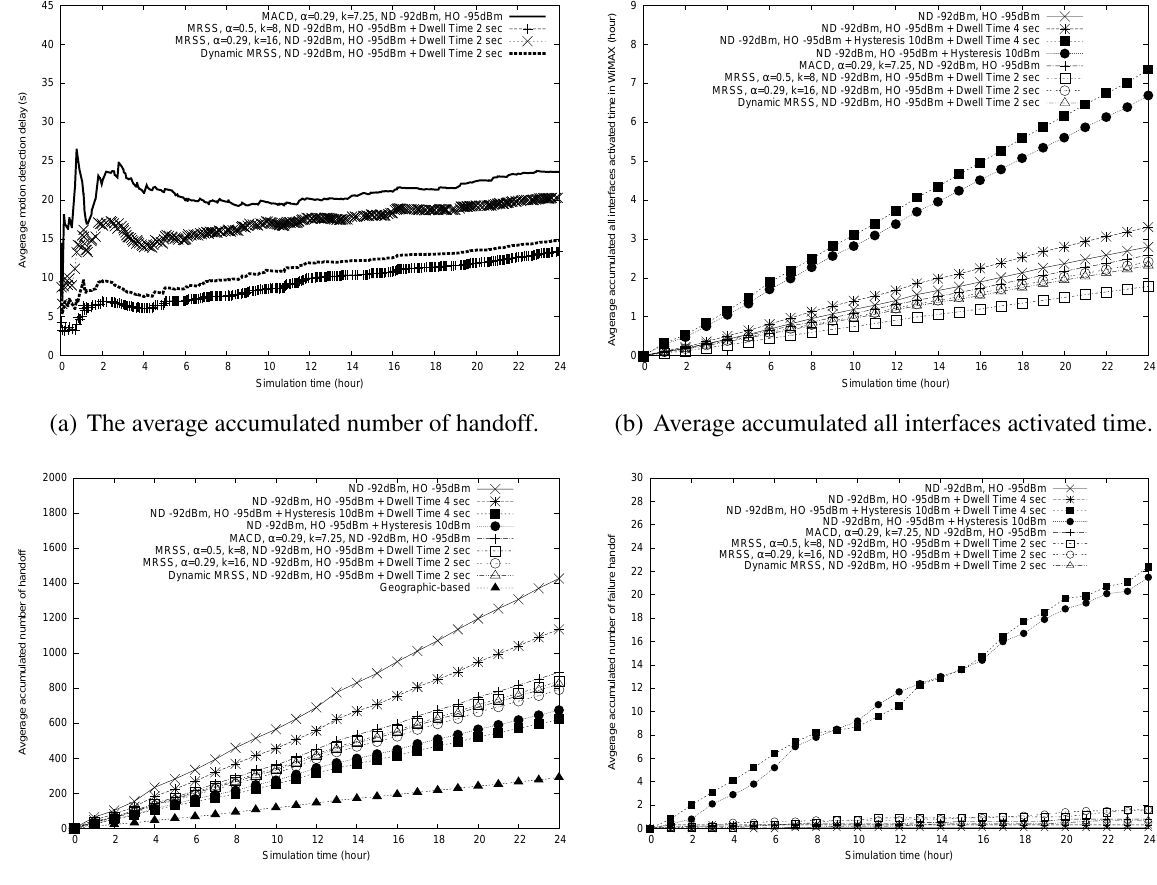
Figure 15. The performance analysis of MRSS-based handoff algorithm in the Mobile WiMAX